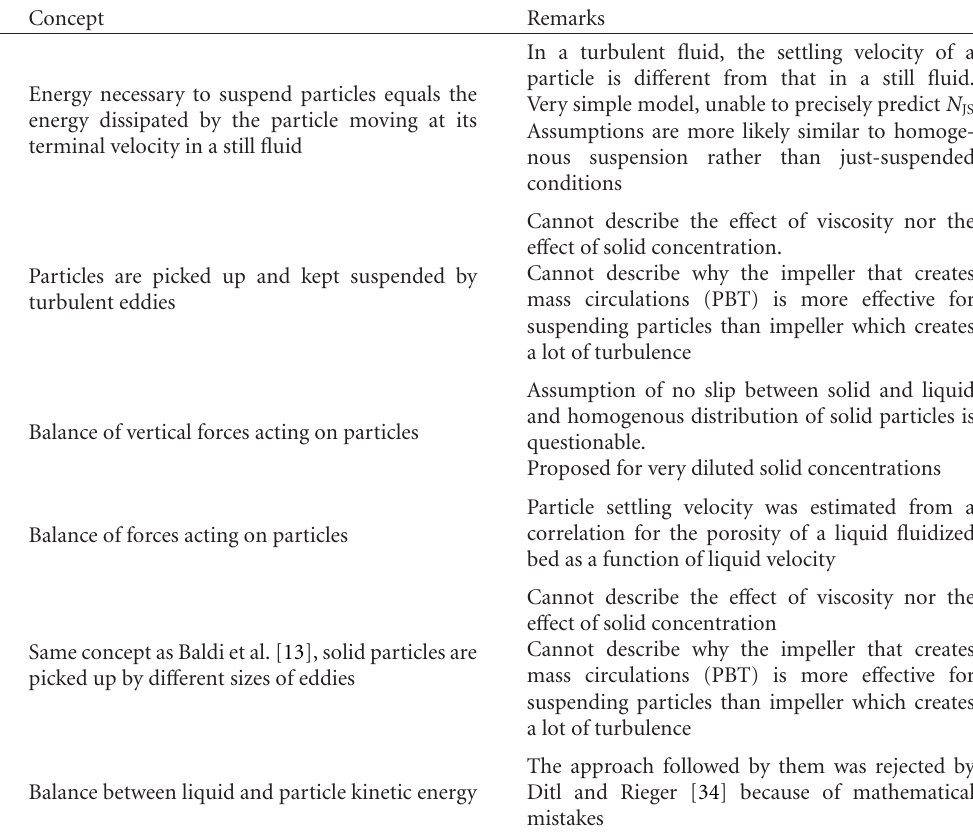
Table 2: Theoretical methods for predicting N JS